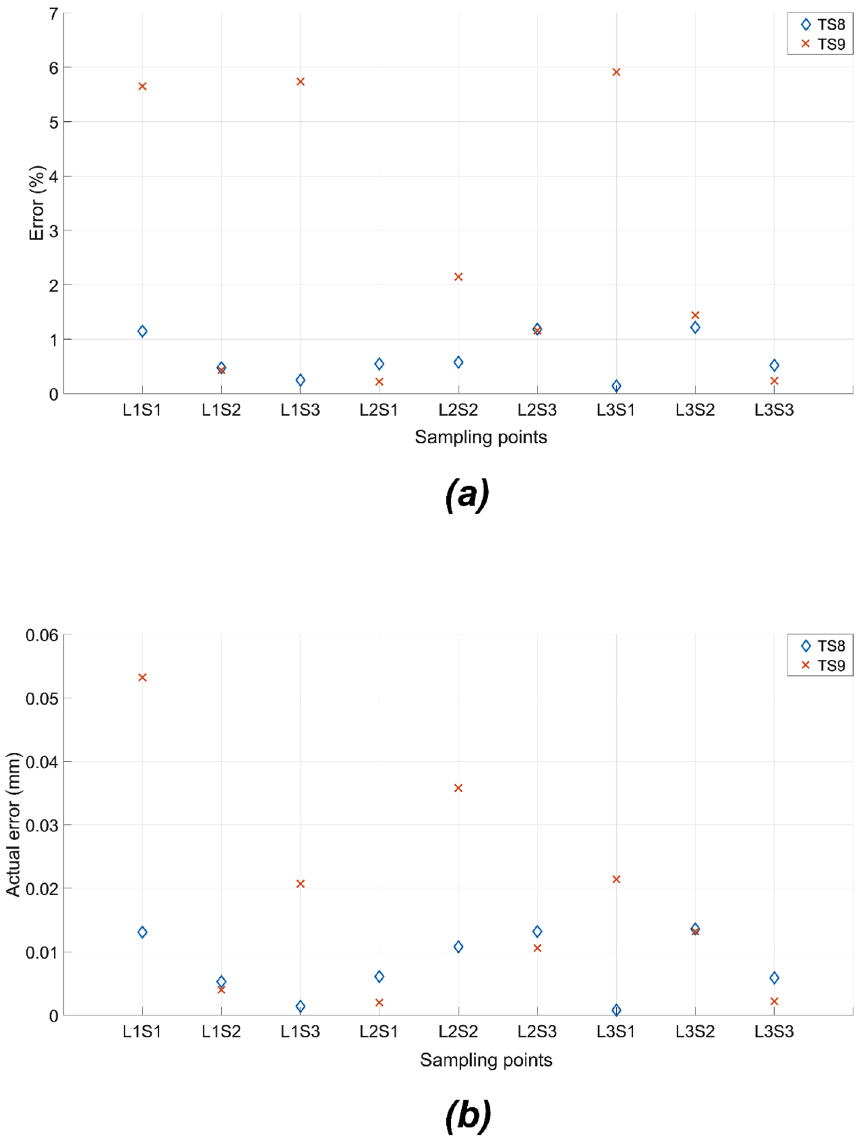
Figure 15. The mean of the difference between the deflection in nine sampling points and the corresponding target deflections for TS8 and TS9 in 20 voxel double void models is expressed as ( a ) percentage and ( b ) actual deflection difference. Each data point corresponds to the mean value of 5 independent